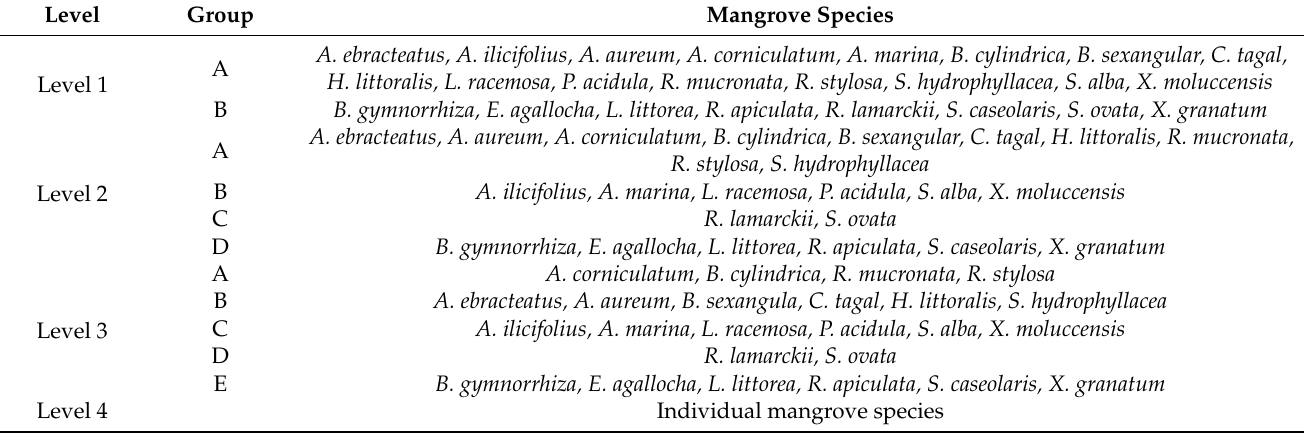
Table 3. Mangrove species grouping of Levels 1–4 resulting from the cluster